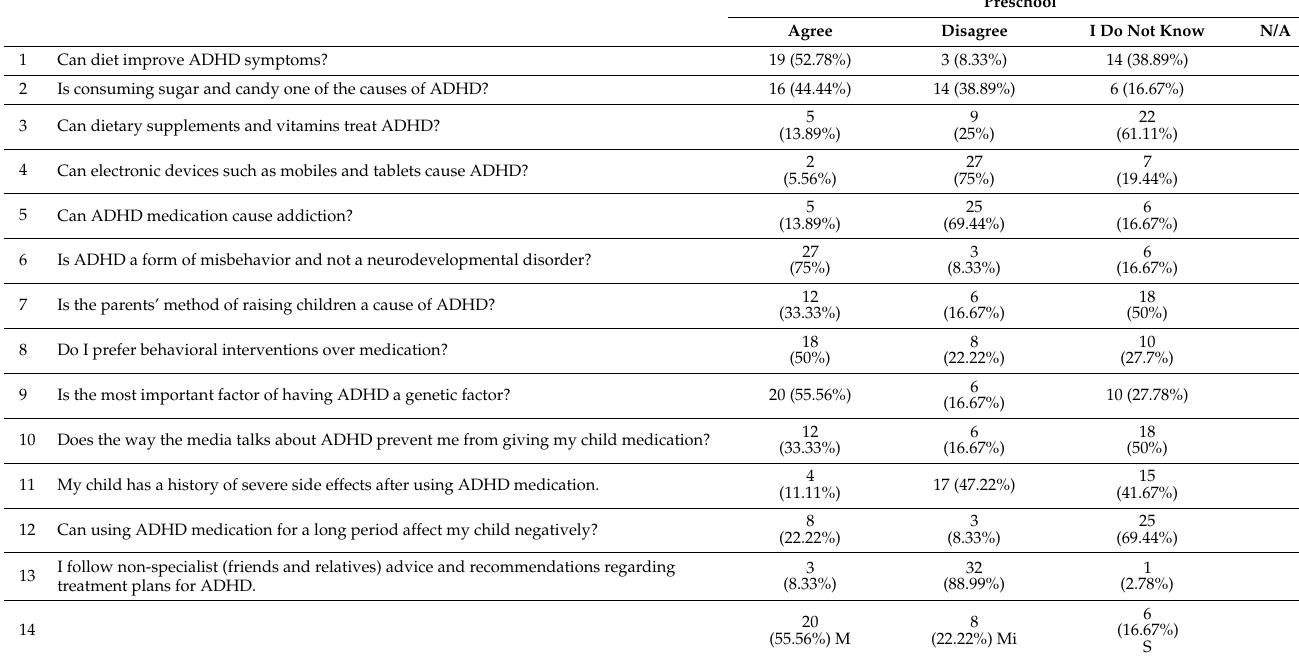
Table 2. Parental responses (preschool group).